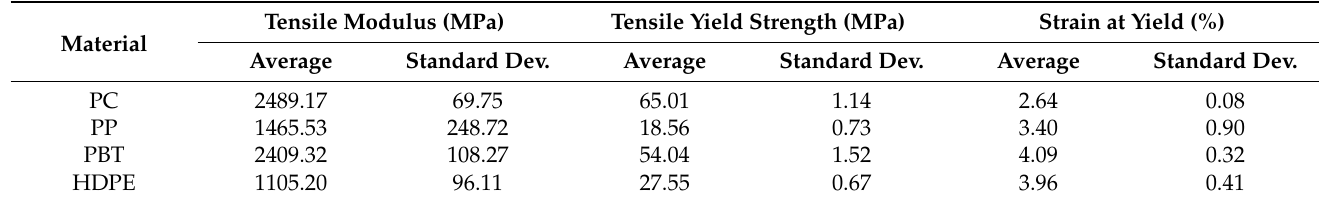
Table 4. Four-year mean values of mechanical properties of weather-exposed